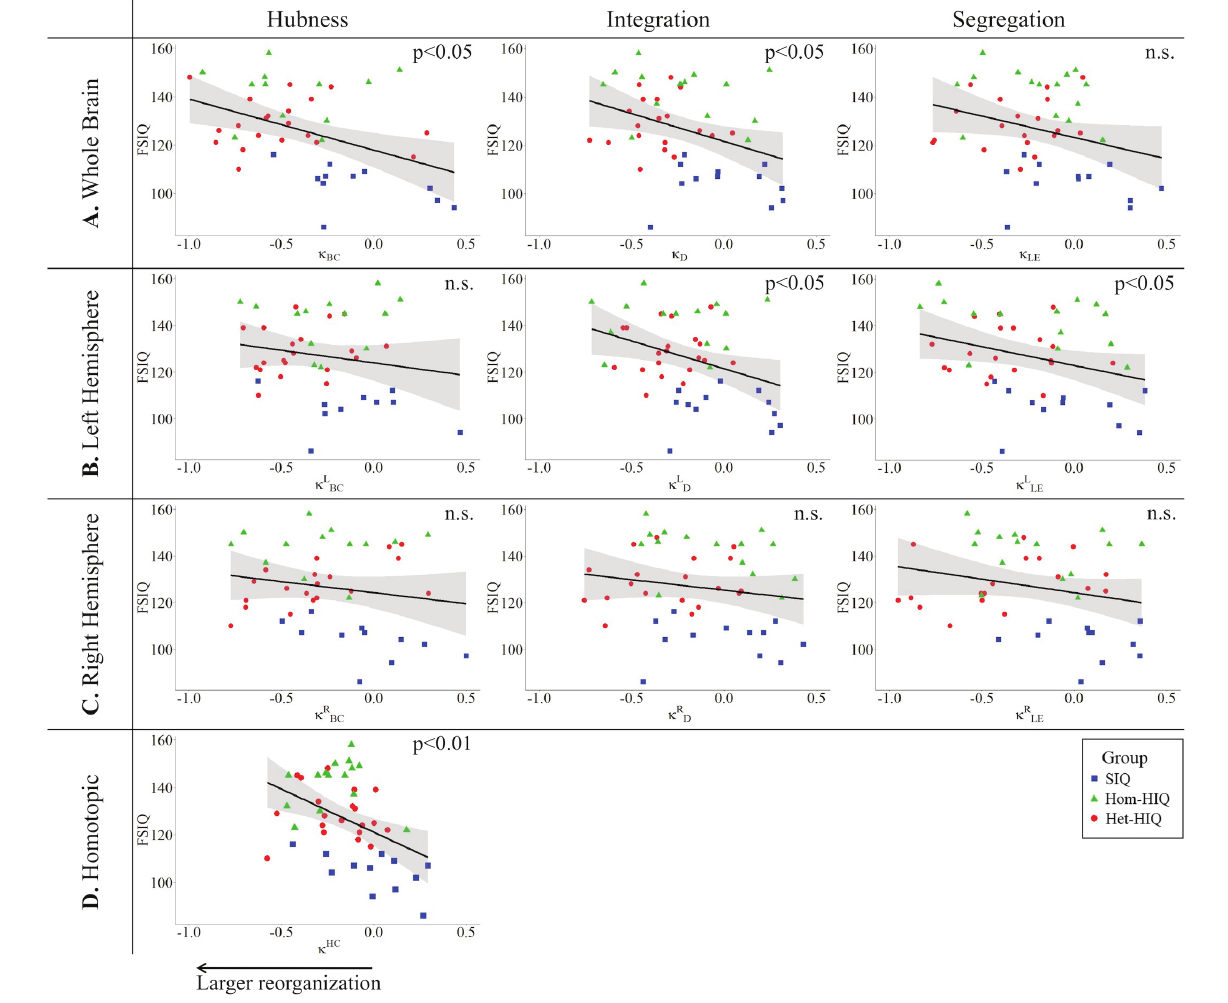
FIGURE 2 | Correlations between full-scale intelligence quotient (FSIQ) and hub disruption indices ( κ ) of graph metrics measured in: (A) the whole brain networks, (B) the left hemisphere networks, (C) the right hemisphere networks, and (D) the homotopic nodes. Significant correlations were measured for κ describing hubs ( κ BC ) and integration properties ( κ D ) in the whole brain networks, for integration and segregation properties in the left hemisphere networks ( κ L D and κ L LE ) and for homotopic connectivity ( κ HC ). No significant correlations were found in the right hemisphere